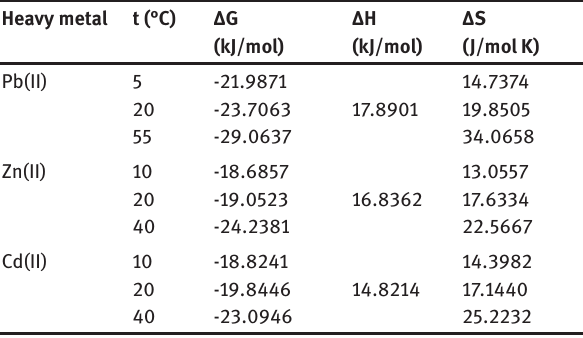
Table 6: Thermodynamic parameters for Pb(II), Zn(II) and Cd(II) biosorption onto mustard waste biomass.